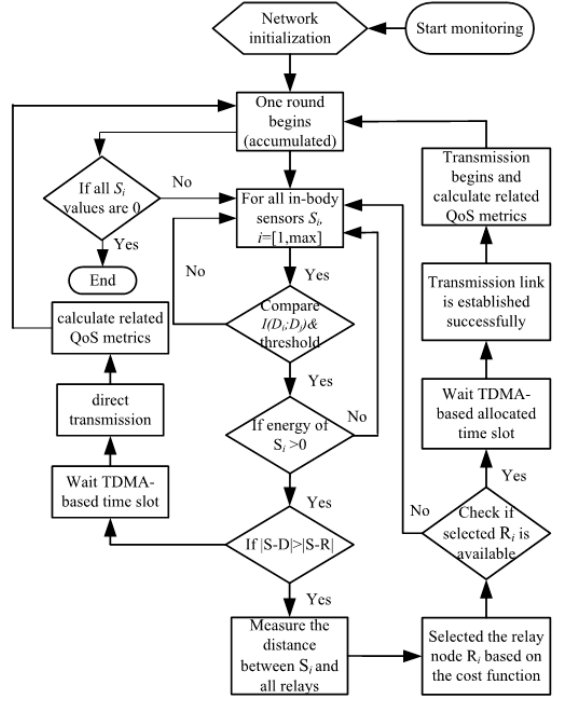
Figure 2. The communication flow of the proposed protocol.